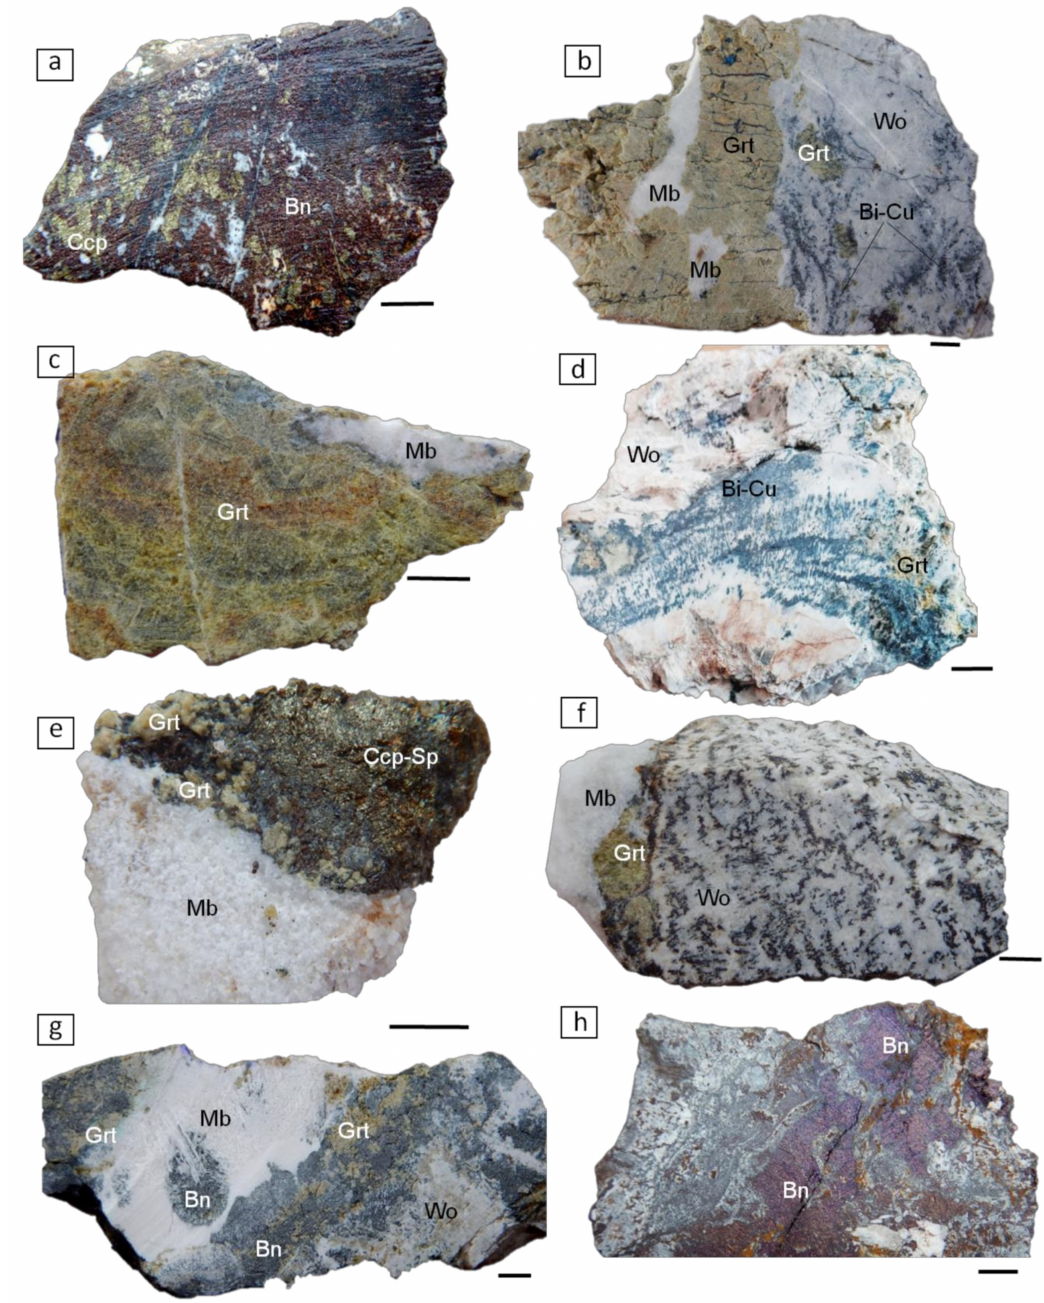
Figure 2. Representative samples from the Antoniu (a—4661), Antoniu North (b—4662, c—4667, d—4669; e—4670, f—5093, g—5094) and Blidar Contact orebodies (h—5095); ( a ) massive bornite-chalcopyrite ore (4661); ( b ) grandite skarn with relict marble (left) and wollastonite skarn with Bi-Cu minerals and garnet fragments (right) (4662); ( c ) grandite skarn with relict marble (4667); ( d ) wollastonite skarn with Bi-Cu mineralization and garnet fragments (4669); ( e ) sphalerite-chalcopyrite mineralization, garnet relict, and marble (4670); ( f ) wollastonite skarn bearing bornite; garnets occur between wollastonite skarn and marble (5093); ( g ) grandite-wollastonite skarn with bornite and relict marble (5094); ( h ) massive bornite-chalcopyrite ore (5095). Scale bar: 1 cm. Abbreviations: Bi-Cu: bornite-wittichenite dominant; Bn: bornite; Ccp: chalcopyrite; Sp: sphalerite; Grt: garnet; Mb: marble; Wo: